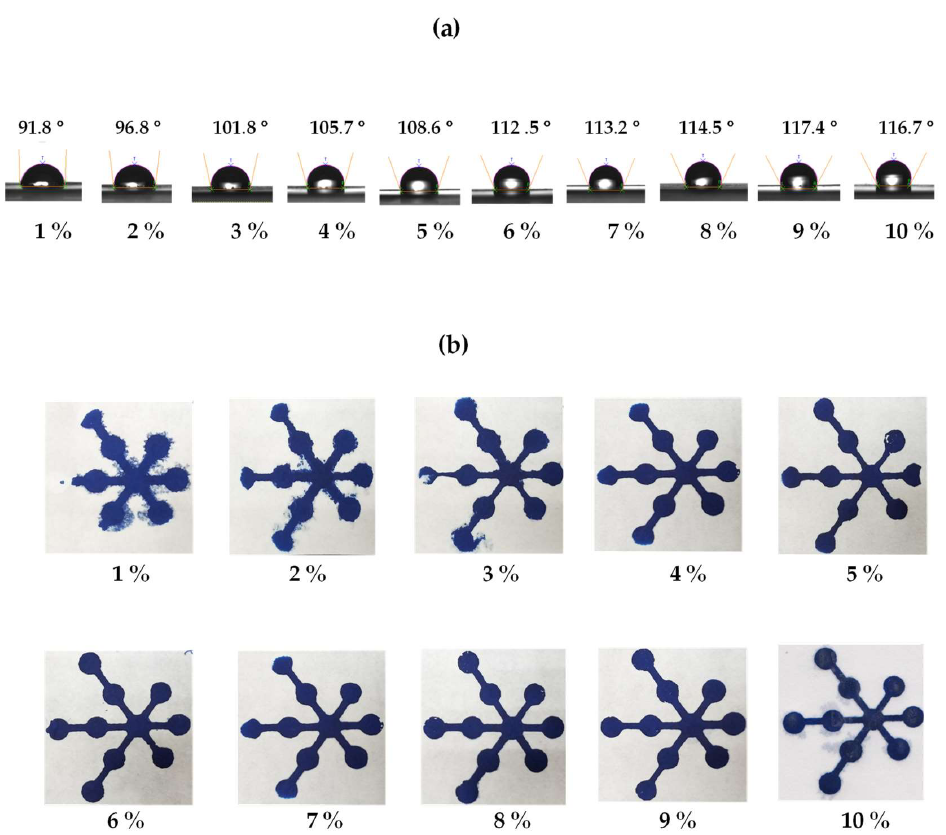
Figure 4. ( a ) Contact-angle images and ( b ) photographs of the blue dye solution in the hydrophilic microchannels to indicate the hydrophilic regions.